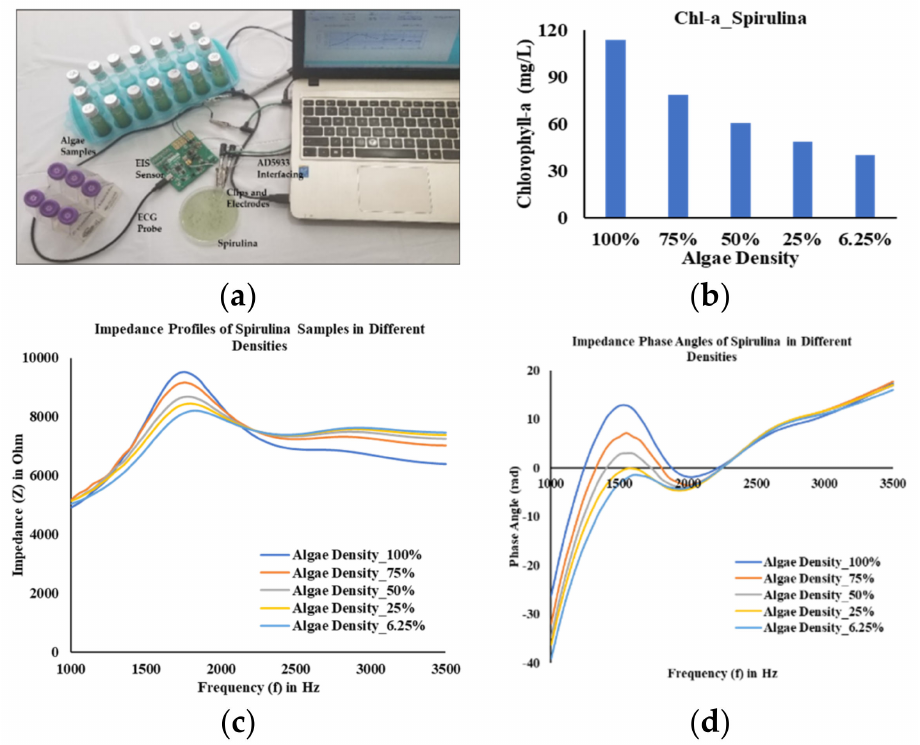
Figure 2. ( a ) EIS measurement setup for algae samples, ( b ) Chlorophyll-a for Spirulina samples, ( c ) the corresponding impedance profiles, and ( d ) the phase angles at different densities of Spir- ulina. The variation in algae density changes the impedance because of the different Chlorophyll-a concentrations of the